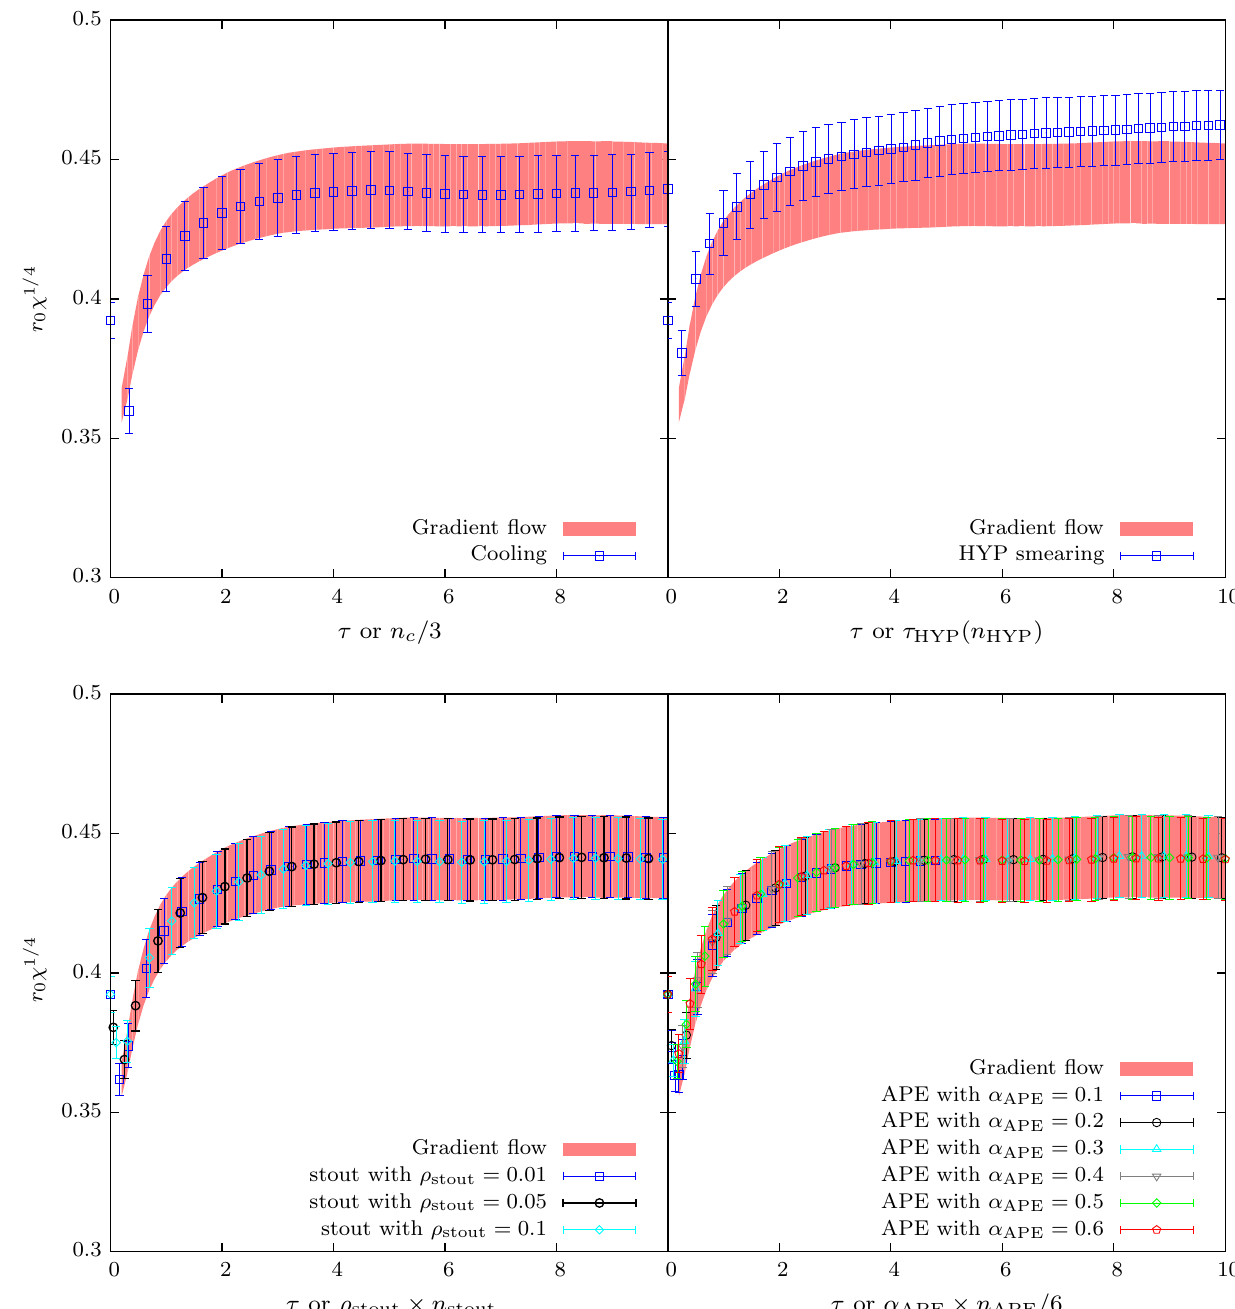
Fig. 13 A comparison of the topological suscpeptibility r 0 χ 1 / 4 as a function of the gradient flow time τ for the Wilson flow, or, in the upper left panel, the rescaled cooling step n c / 3 for cooling, or, in the upper right panel, the rescaled HYP smearing τ HYP ( n HYP ) , or, in the